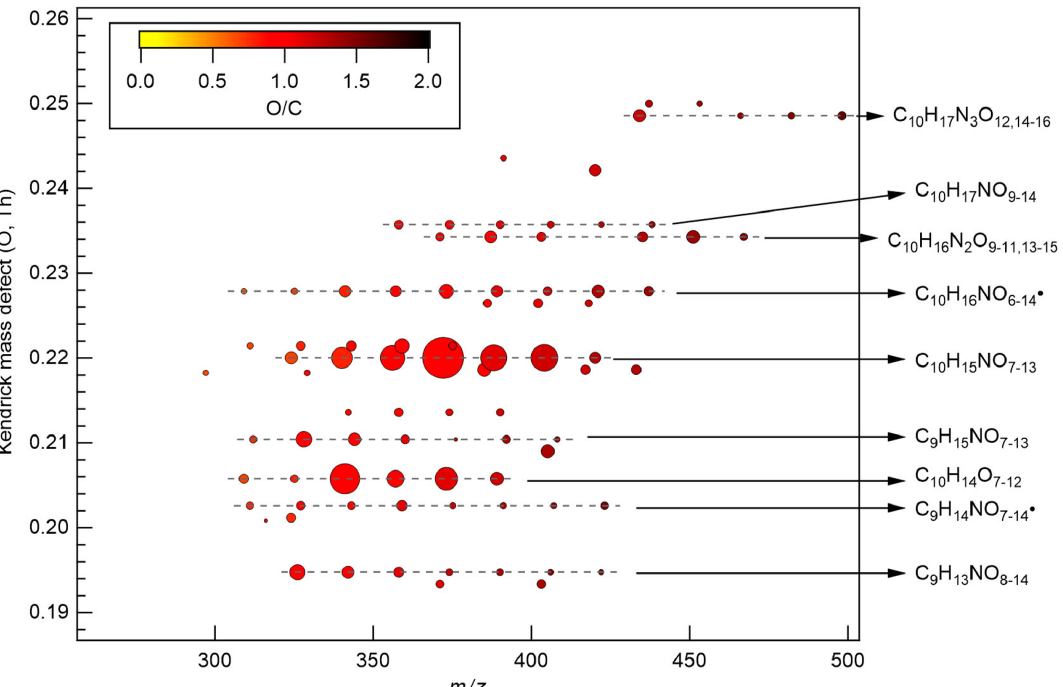
Figure 3. Kendrick mass defect plot (O-atom-based) of major monomer products. The area of the circles is proportional to the average intensity of each compound during the P1a period with the largest circle representing C 10 H 15 NO 10 . The color denotes O / C ratios. Dashed lines indicate major product families. For clarity, the reagent ions 15 NO − are omitted from molecular formula. The calculation of O-atom- 3 based Kendrick mass defect includes two steps. First, the IUPAC mass scale (based on the 12 C atomic mass as exactly 12Da) is rescaled to Kendrick mass: Kendrick mass = IUPAC mass × (16 / 15 . 9949), which converts the mass of O from 15.9949 to exactly 16. Then, Kendrick mass defect is given by Kendrick mass defect = nominal Kendrick mass − exact Kendrick mass. Thus, compounds with the same number of each kind of atom except for O have equal O-atom-based Kendrick mass defect, and are shown in a horizontal line in the O-atom-based Kendrick mass defect